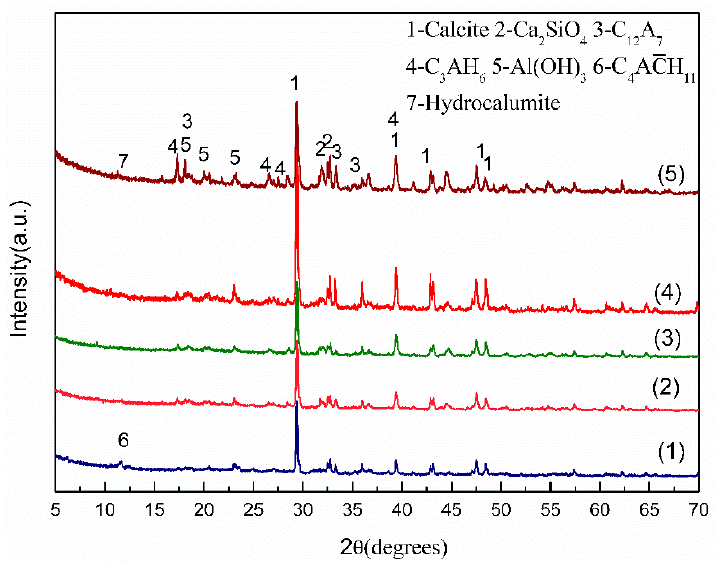
Figure 5. XRD patterns of (1) carbonated 20H-slag, (2) carbonated 40H-slag, (3) carbonated 60H-slag, (4) carbonated 80H-slag, and (5) carbonated 100H-slag.